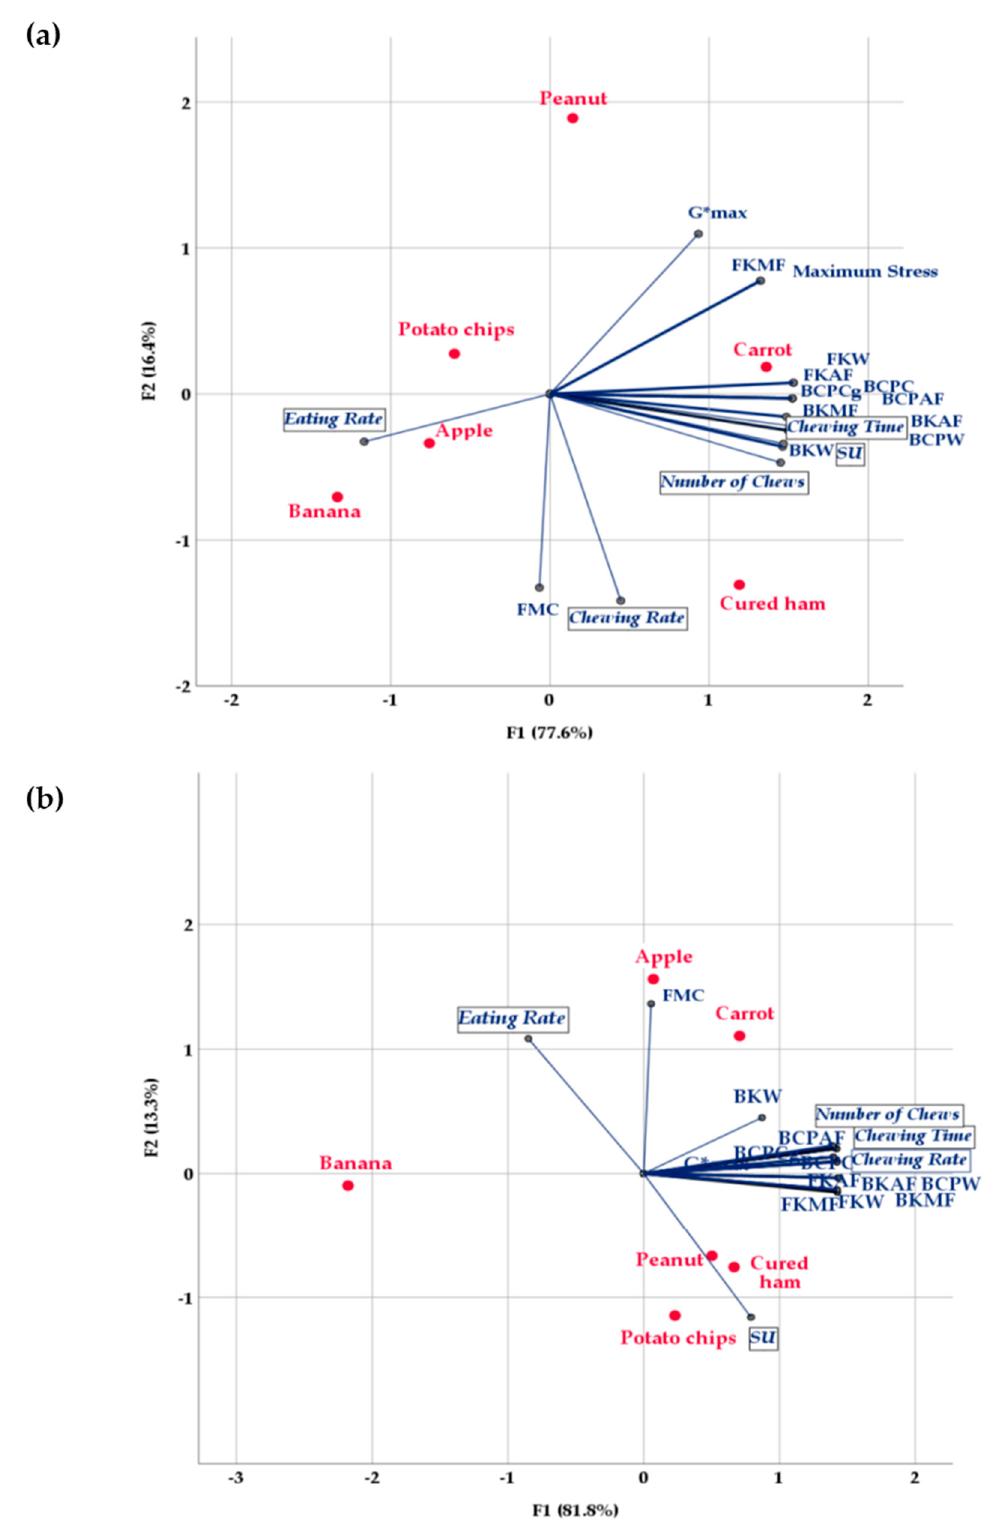
Figure 3. CATPCA plot showing variation in food products regarding instrumental measurements and oral processing behaviors: ( a ) of the young volunteer; ( b ) of the 39 untrained participants. Abbreviations are spelled out in Tables 1, 2, 4, 5.